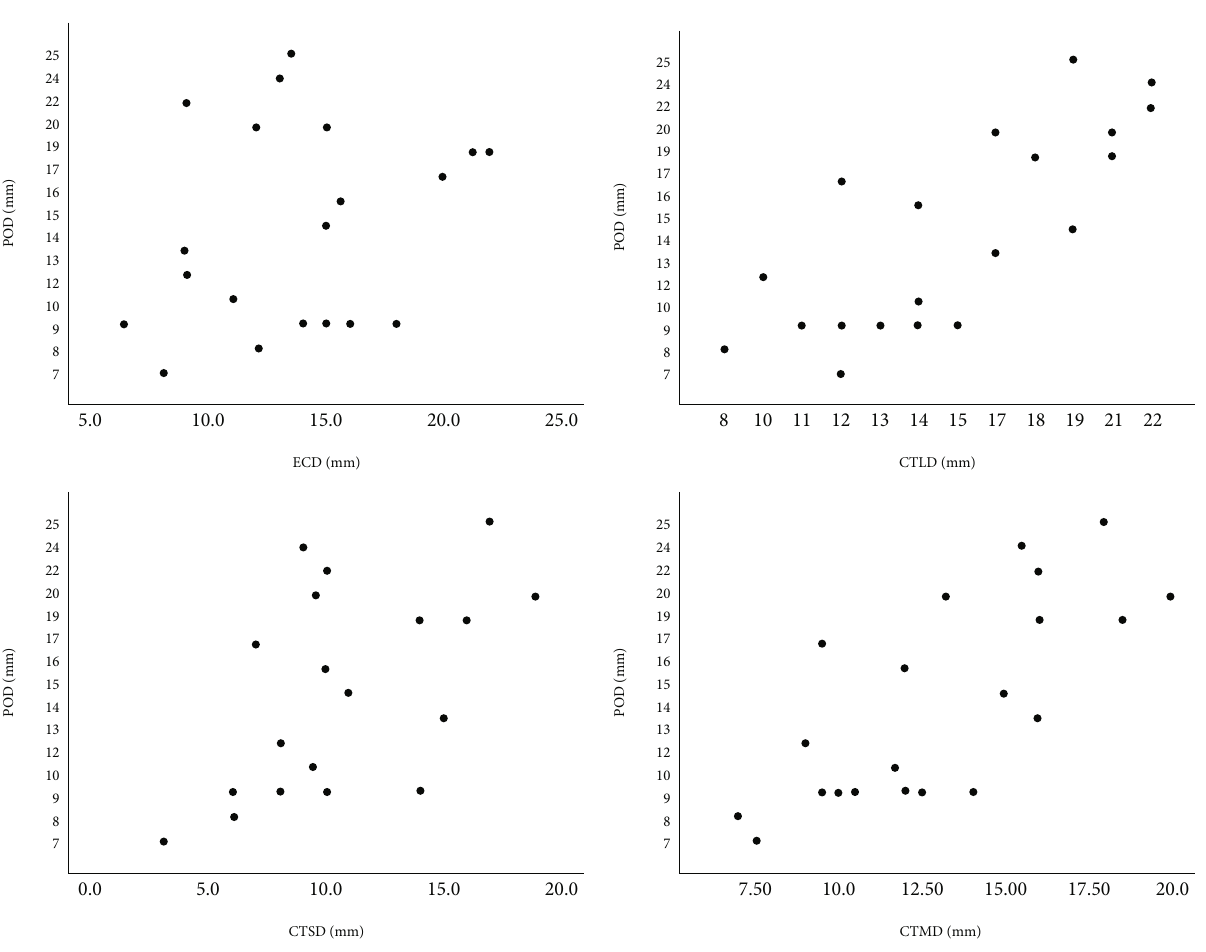
Figure 2: Scatter diagram of POD and ECD/CTLD/CTSD/CTMD. Table 4: Correlation between POD and di ff erent measurement methods in the CTA